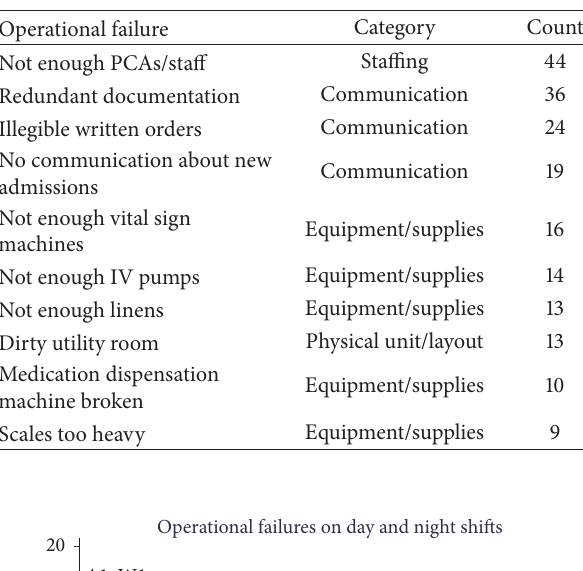
Table 3: Most commonly reported operational failures.